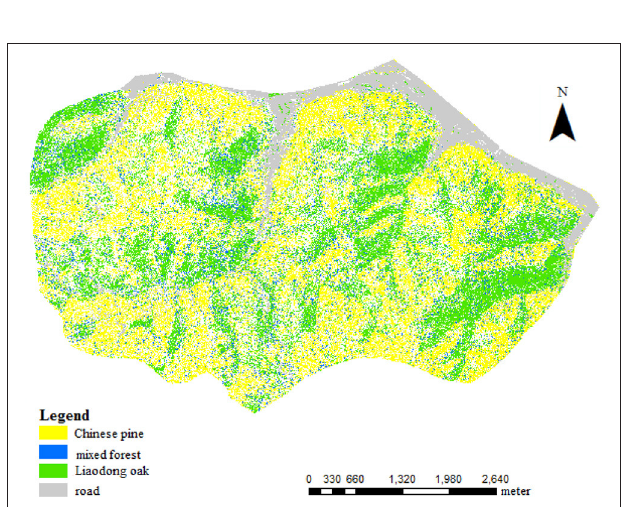
FIGURE 4 | The result of object-oriented classification.